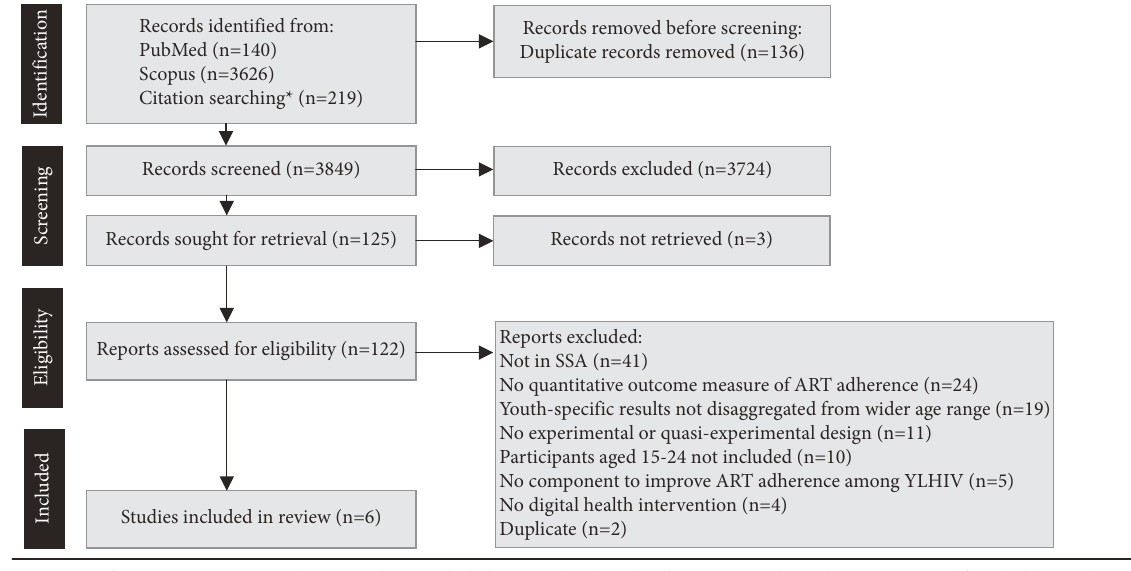
Figure 1: PRISMA study selection flow